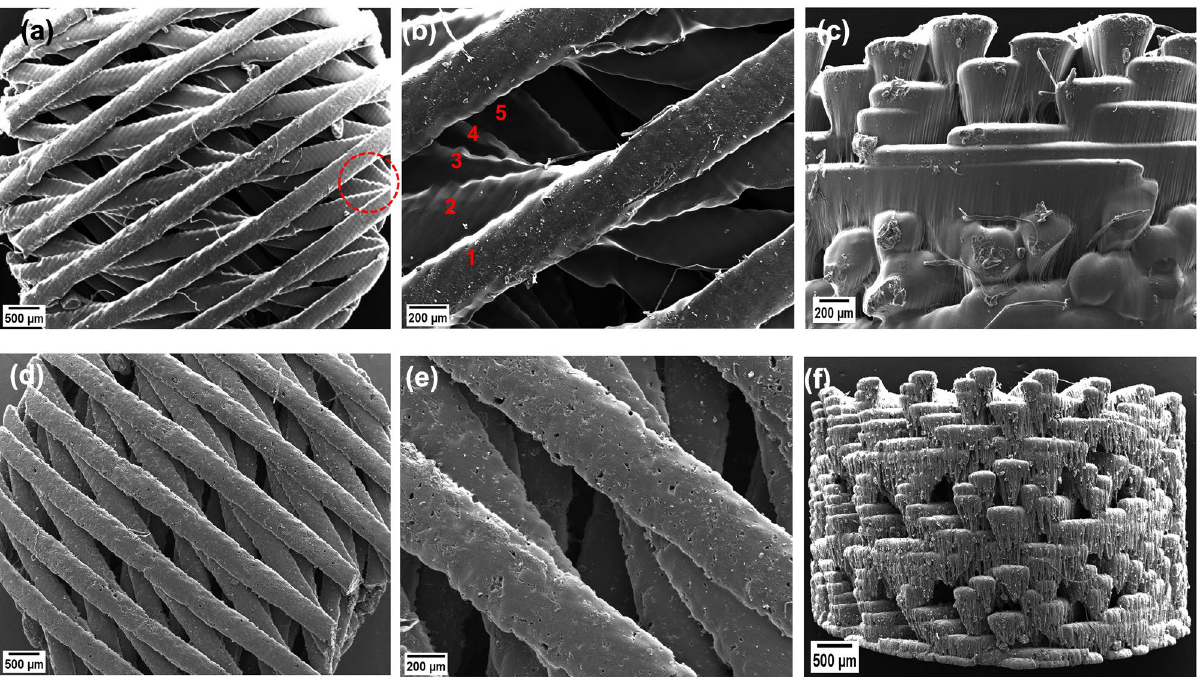
Figure 6. Hierarchical morphology of the printed scaffolds. ( a ) PEGDA scaffold at 44X while the circle indicates strands rotation deep into the scaffold, and ( b ) PEGDA scaffold at 133X while numbers indicate layer 1 on top and the subsequent layers deep into the scaffold rotating at certain angles, ( c ) cross-section of the at 107X, ( d ) PEGDA scaffold with 2.0% PANI at 44X, and ( e ) at 133X, ( f ) cross-section at 67X representing various layers deposited on top of each other during 3D printing